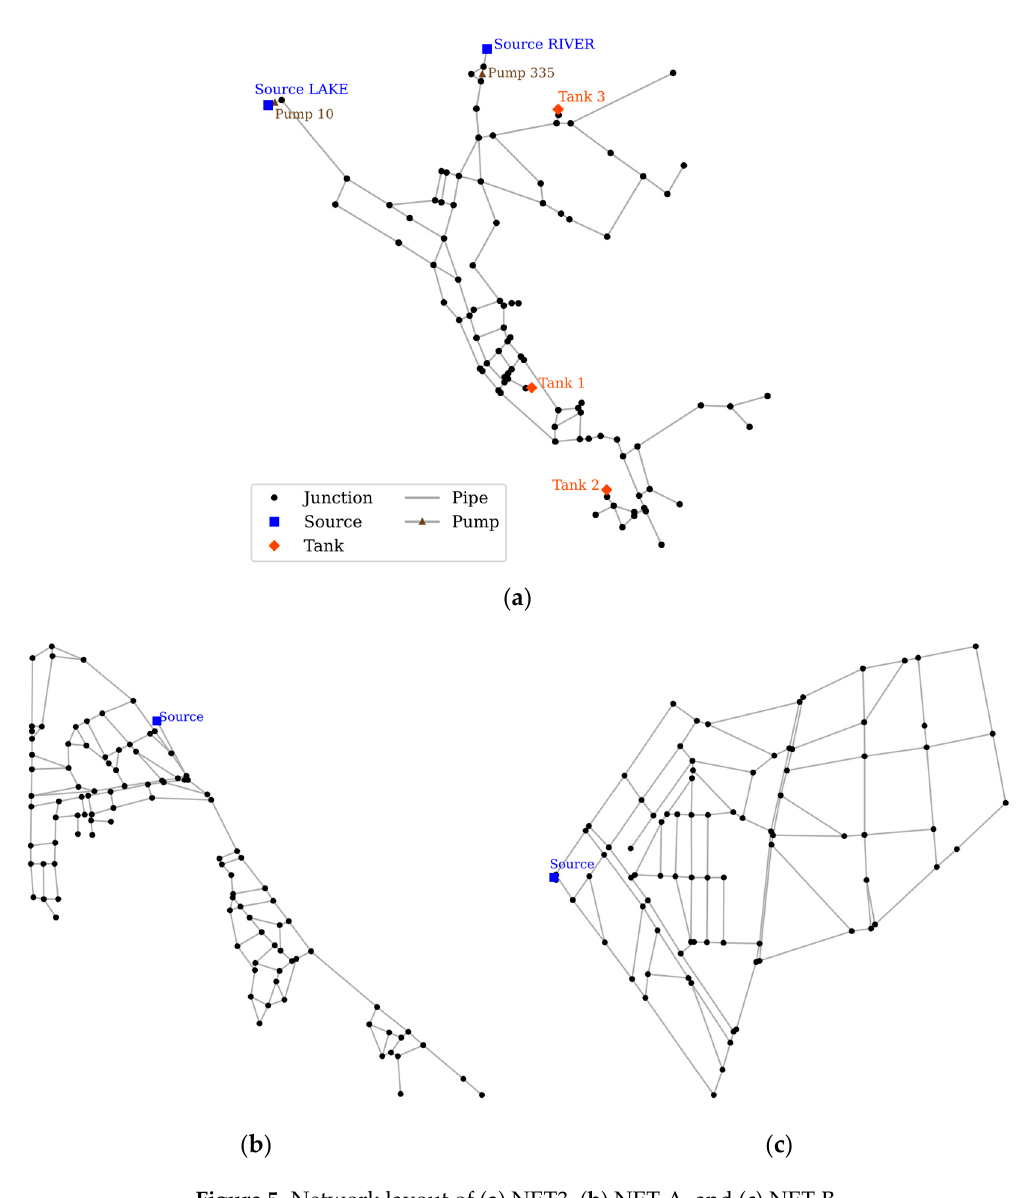
Figure 5. Network layout of ( a ) NET3, ( b ) NET-A, and ( c ) NET-B. Table 2. Network details.